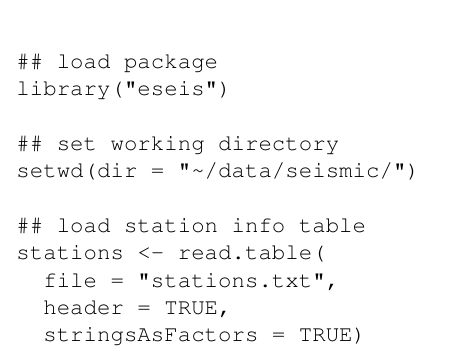
Figure 3. Plot types to visualise particle motion. (a) 2-D plots of the components, (b) 3-D perspective plot, and (c) a screen shot of an interactive scene that can be rotated and